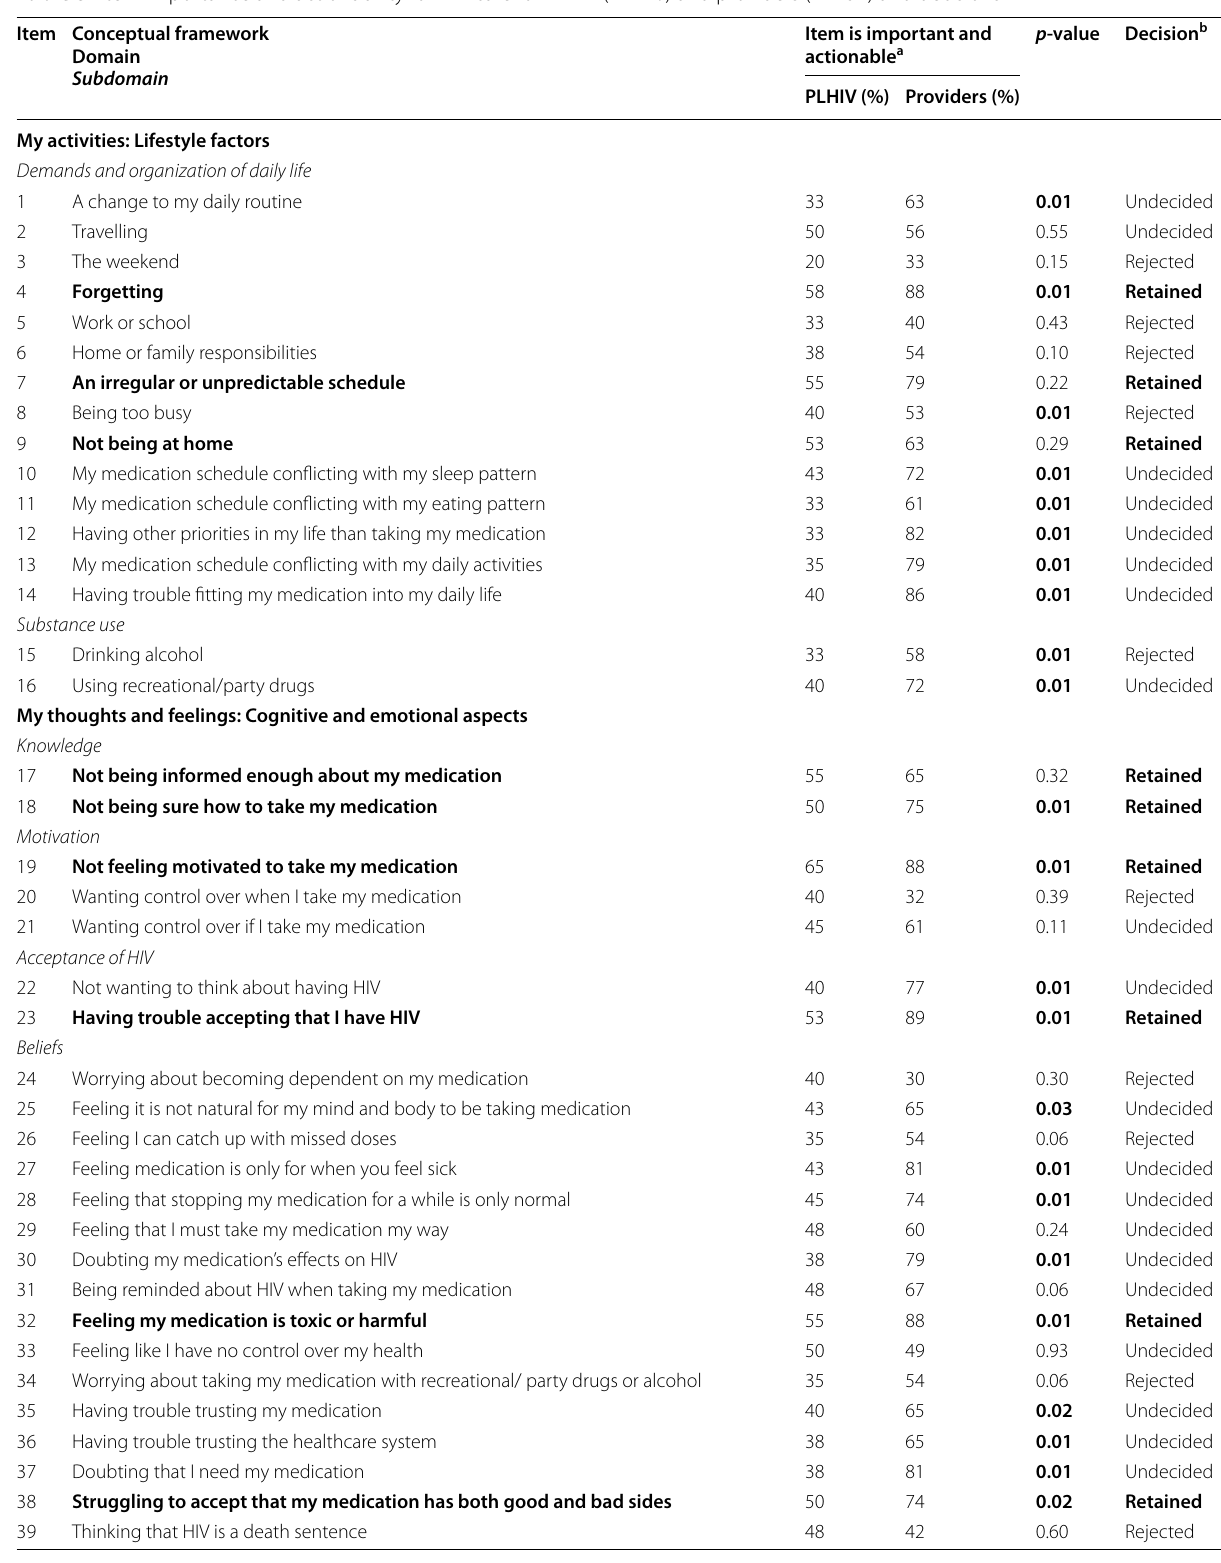
Table 3 Item importance and actionability for HIV care for PLHIV (n